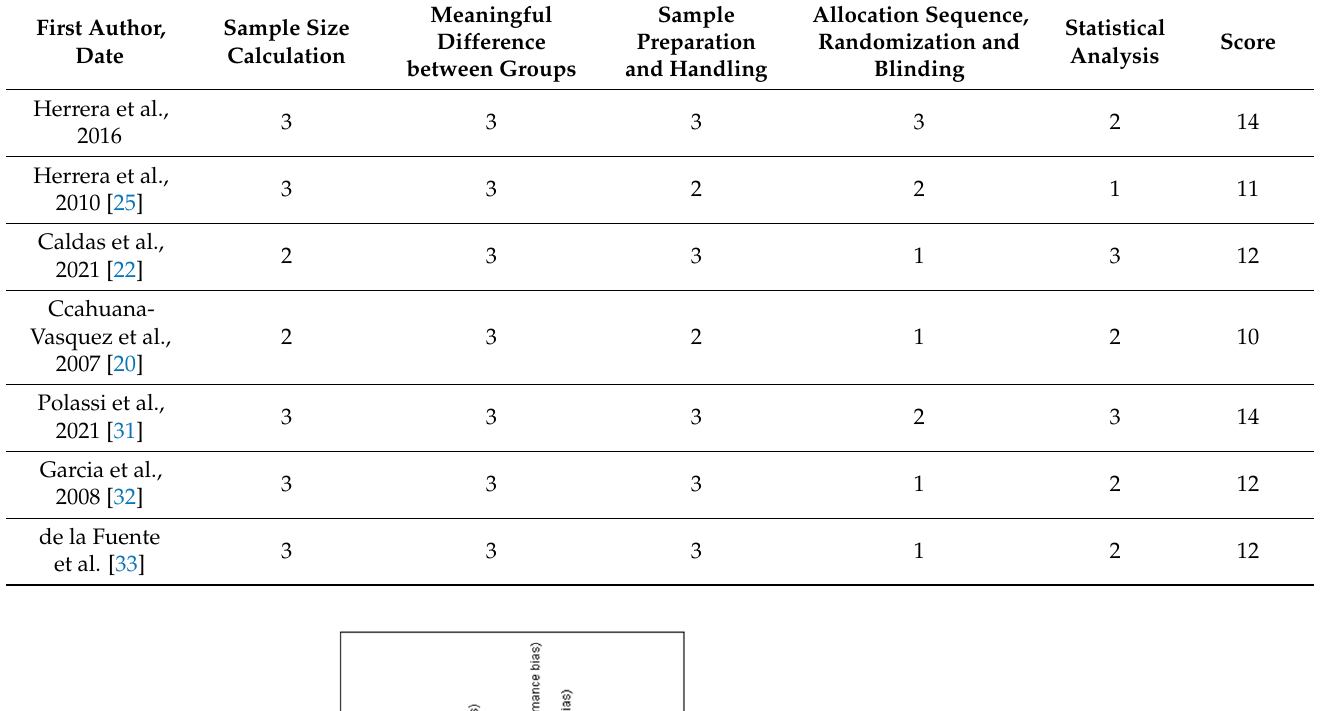
Table 4. Assessment of the risk of bias within the studies, with scores of 5 to 9 indicating low quality, 10 to 12 intermediate quality and 13 to 15 high quality.